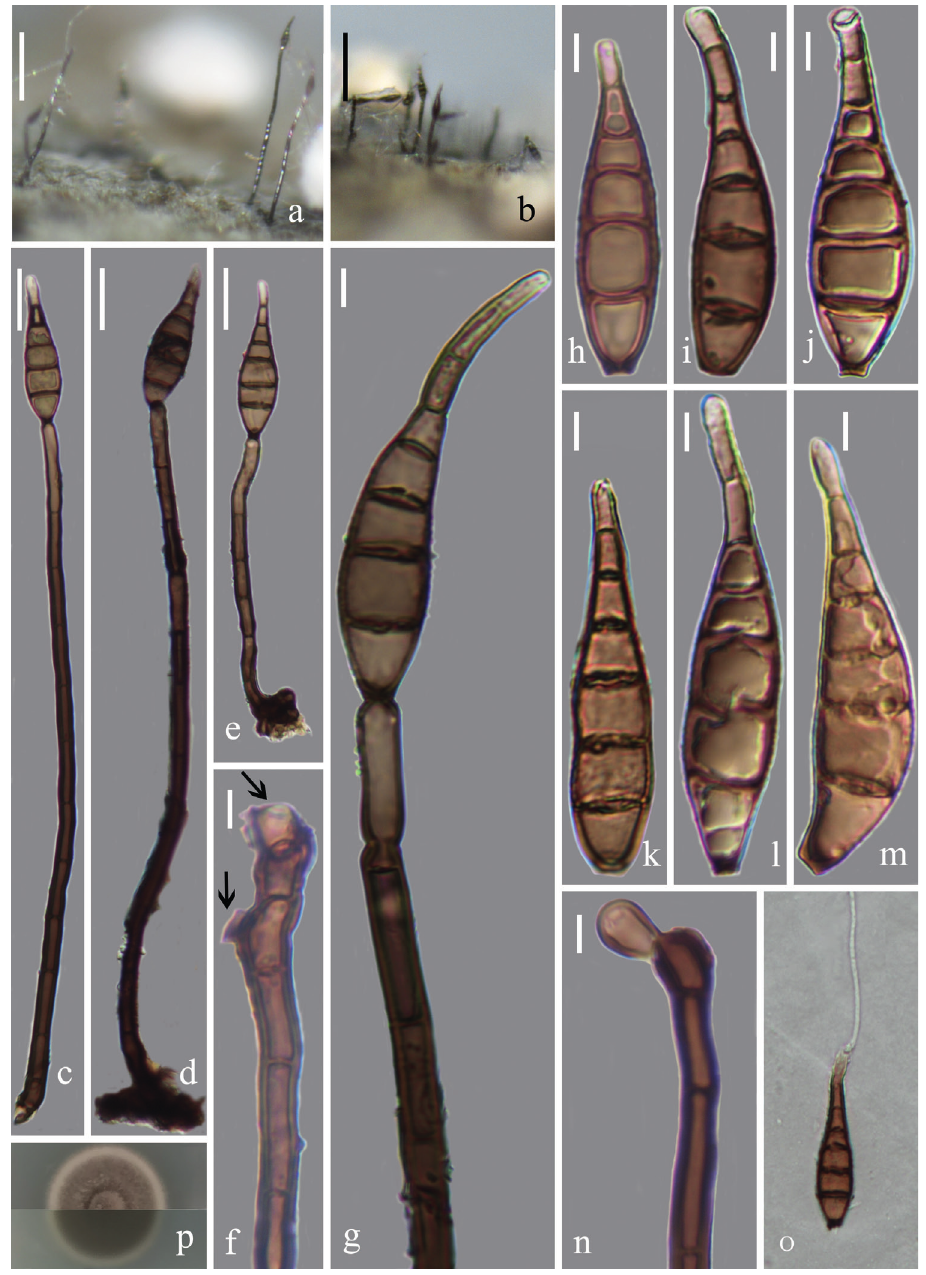
Figure 2. Distoseptispora meilingensis (HFJAU10009, holotype) a, b colonies on bamboo culms c–e conidiophores with conidia f conidiogenous cells g, n conidiogenous cells with conidia h–m conidia o germinating conidium p culture on PDA from above and reverse. Scale bars: 100 μm ( a, b ), 20 μm ( c–e, o ), 5 μm ( f-n